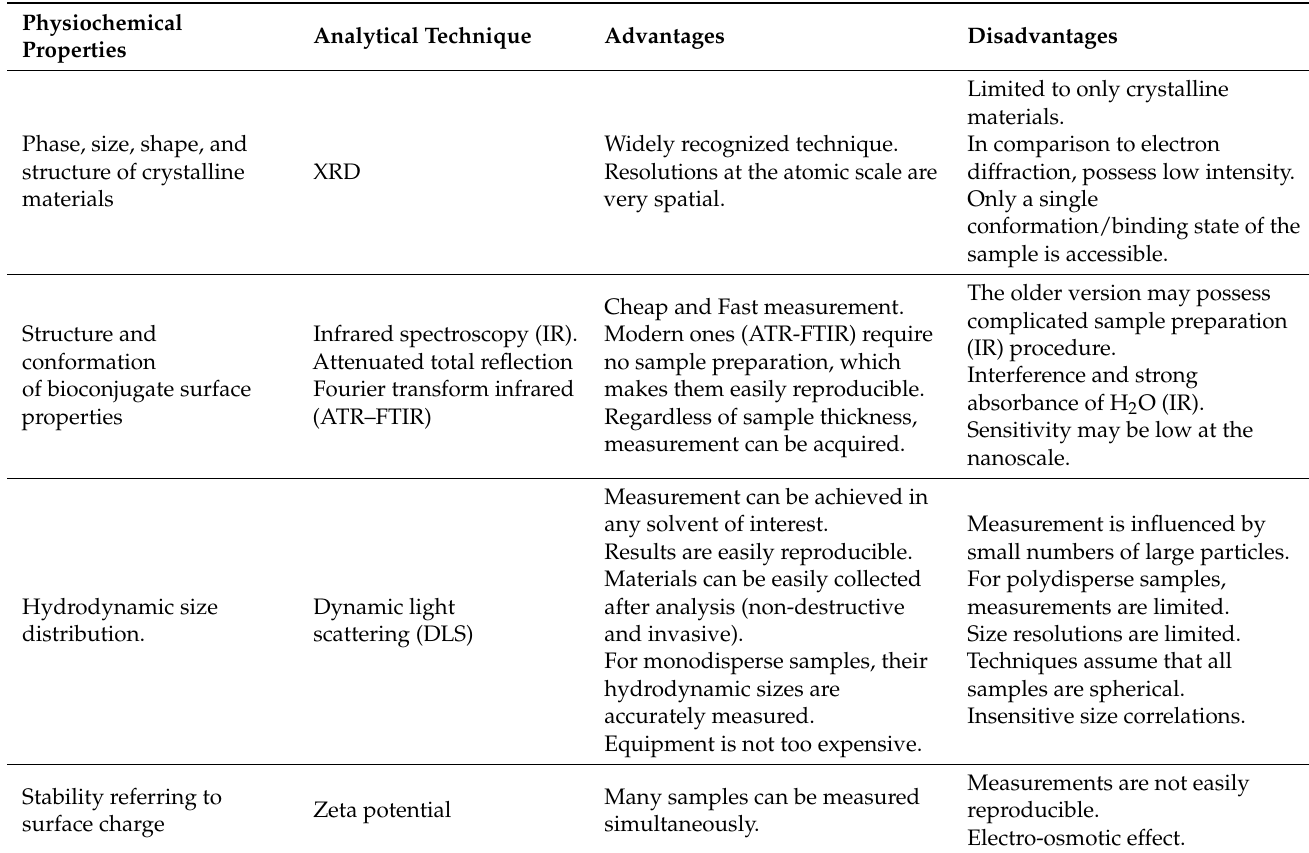
Table 2. Some analytical techniques for the physiochemical characterizations for nanomaterials with their respective advantages and disadvantages. Redrawn from [87], with permission from Elsevier (Copyright